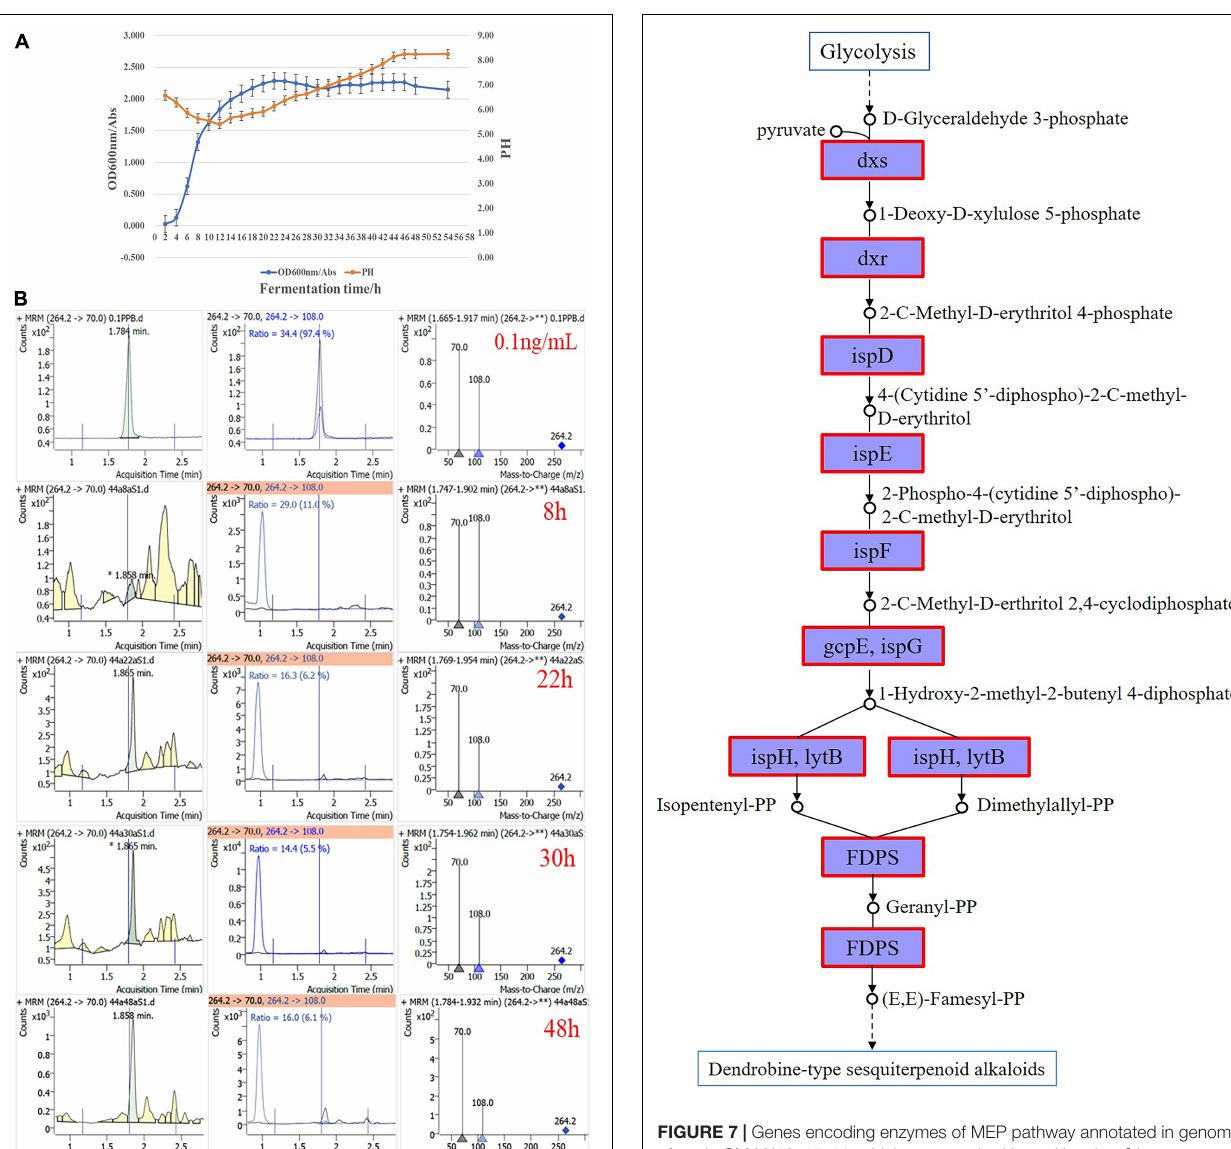
FIGURE 7 | Genes encoding enzymes of MEP pathway annotated in genome of strain CM-YJ10_15-44, which were marked by red borders [dxs